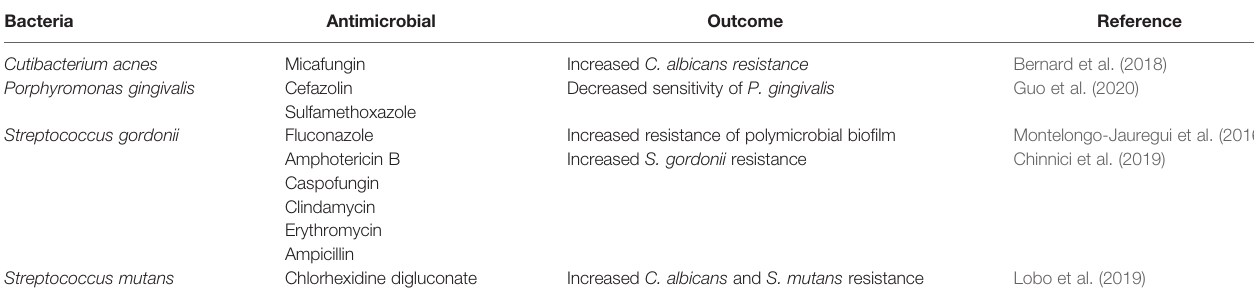
TABLE 2 | Candida albicans -bacteria interactions that in fl uence antimicrobial resistance.